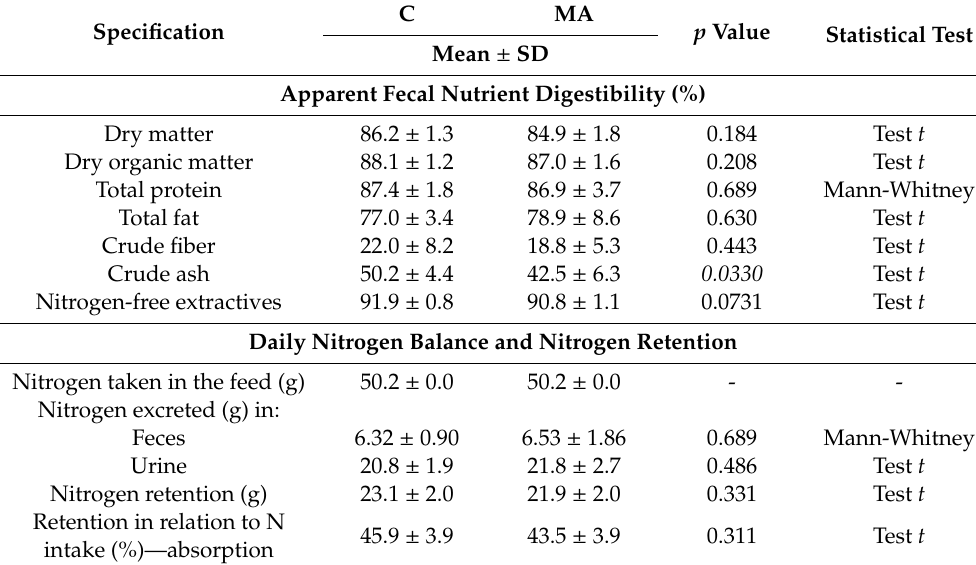
Table 5. Apparent fecal nutrient digestibility (%) and daily nitrogen balance and nitrogen retention.